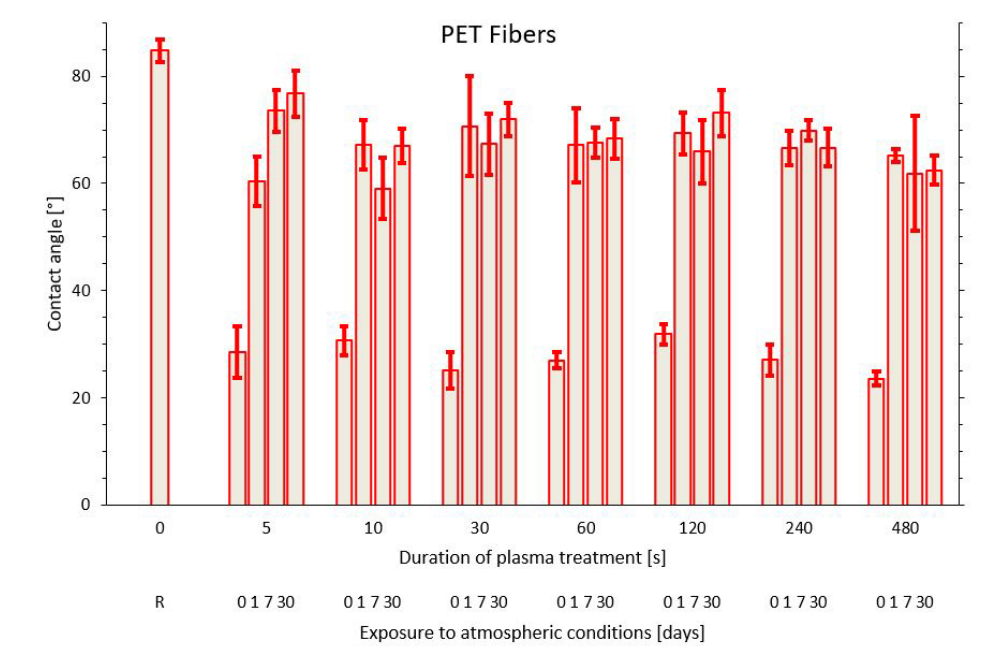
Figure 2. PET fibers – dependence between contact angle, duration of plasma treatment and time of exposure to atmospheric conditions.